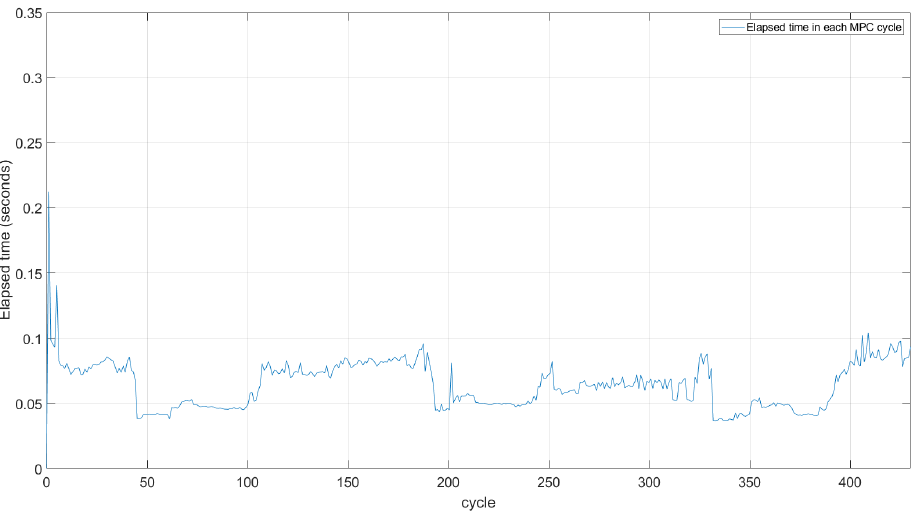
Figure 15. History of the time elapsed on each MPC cycle in the second simulation